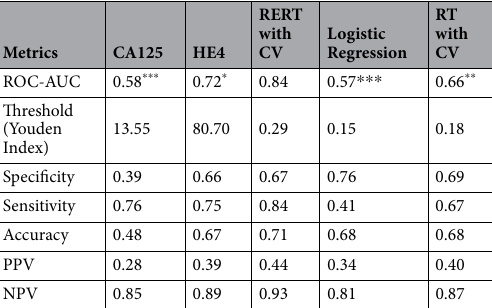
Table 3. Metrics to assess the performance of the proposed methods evaluated in 219 endometrioid EC patients preoperatively classified as early stage (clinical stage). * p-value = 0.02, ** p-value < 0.01, *** p-values < 0.0001: these are p-values of the DeLong’s test or Bootstrap test (underlined) for the comparison of two AUCs (RERT with CV vs other methods). For major details see Table S7 in Supplementary Tables. RT with CV stands for Regression Tree with